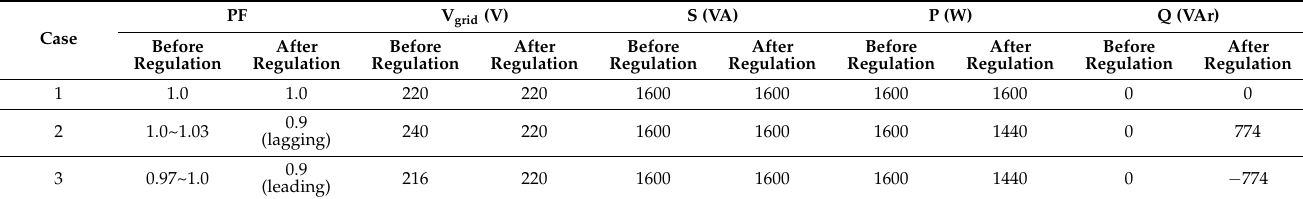
Table 4. Test results of three cases of smart